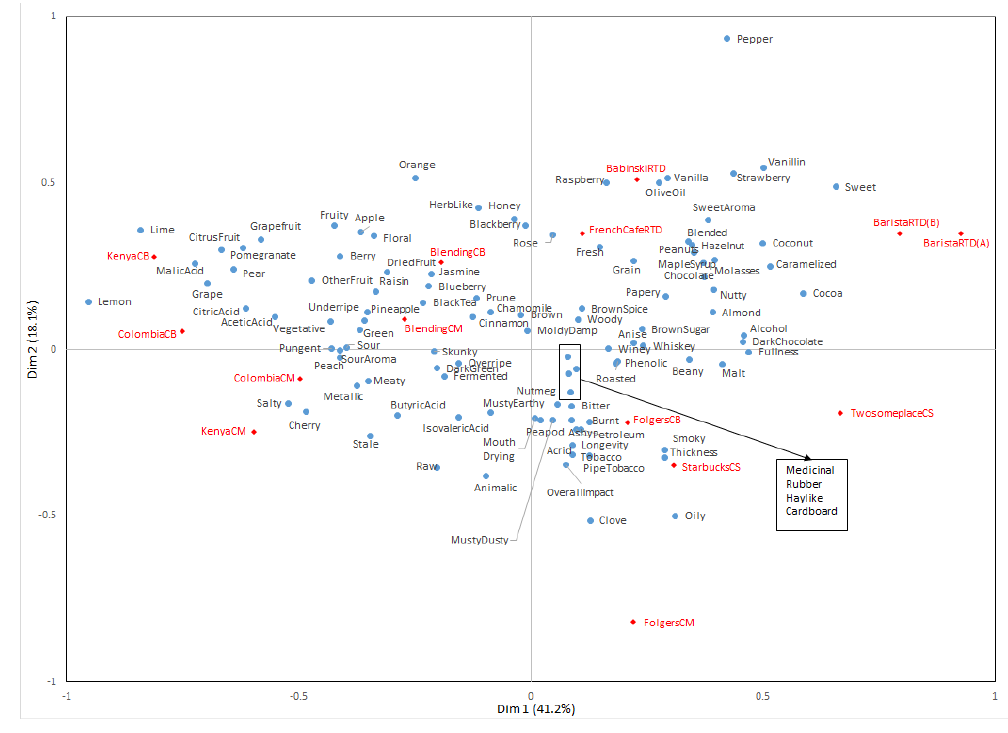
Figure 1. Correspondence analysis of consumers.